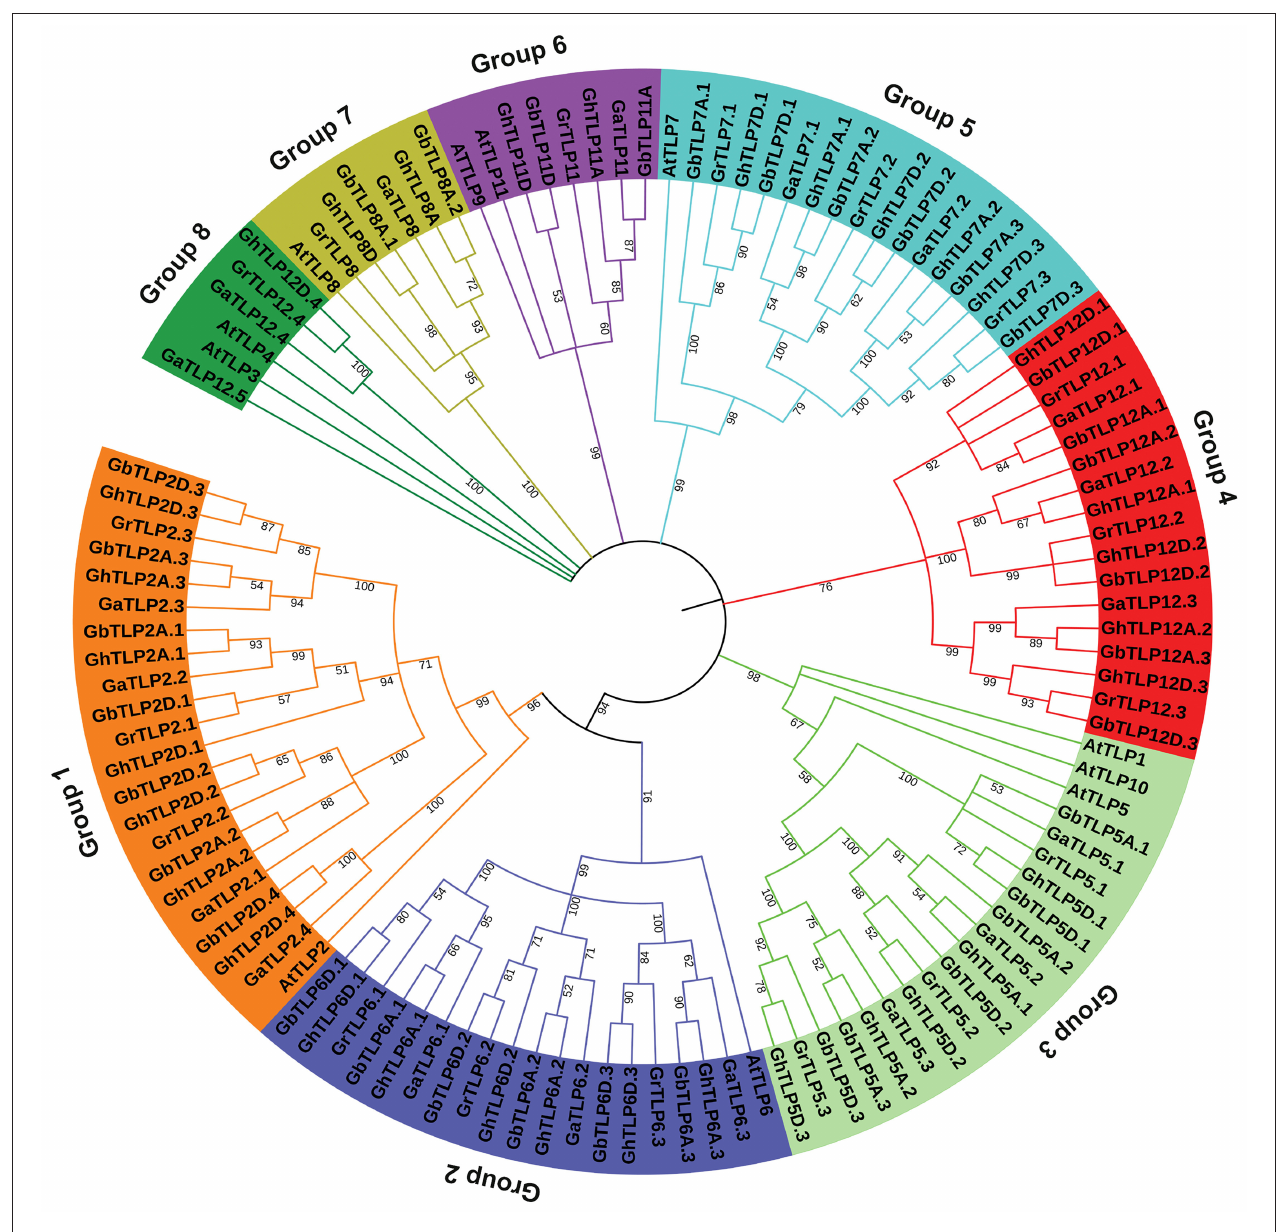
FIGURE 1 | Phylogenetic relationship of Gossypium tubby-like proteins (TLPs) from A. thaliana . The phylogenetic ML tree was built, using the amino acid sequence with 1,000 bootstrap value with MEGA 7.0 software. At, A. thaliana ; Ga, Gossypium arboretum ; Gr, Gossypium raimondii ; Gh, Gossypium hirsutum ; Gb, Gossypium barbadense